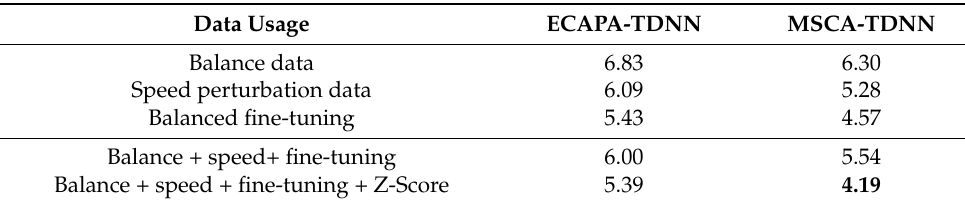
Table 2. The average cost performance (C avg %) of ECAPA-TDNN and MSCA-TDNN under different data usage